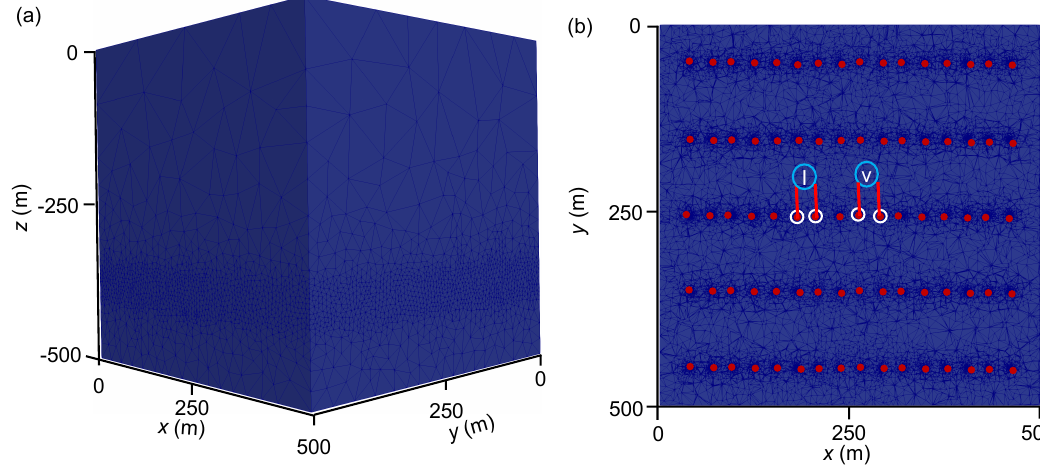
Figure 3. SIP model: ( a ) The three-dimensional (3D) SIP model domain where ( b ) red dots represent electrodes on the xy -plane. White circles represent electrode configuration of 80th out of 1062 simulated electrical impedance where I and V represent current and potential electrodes,